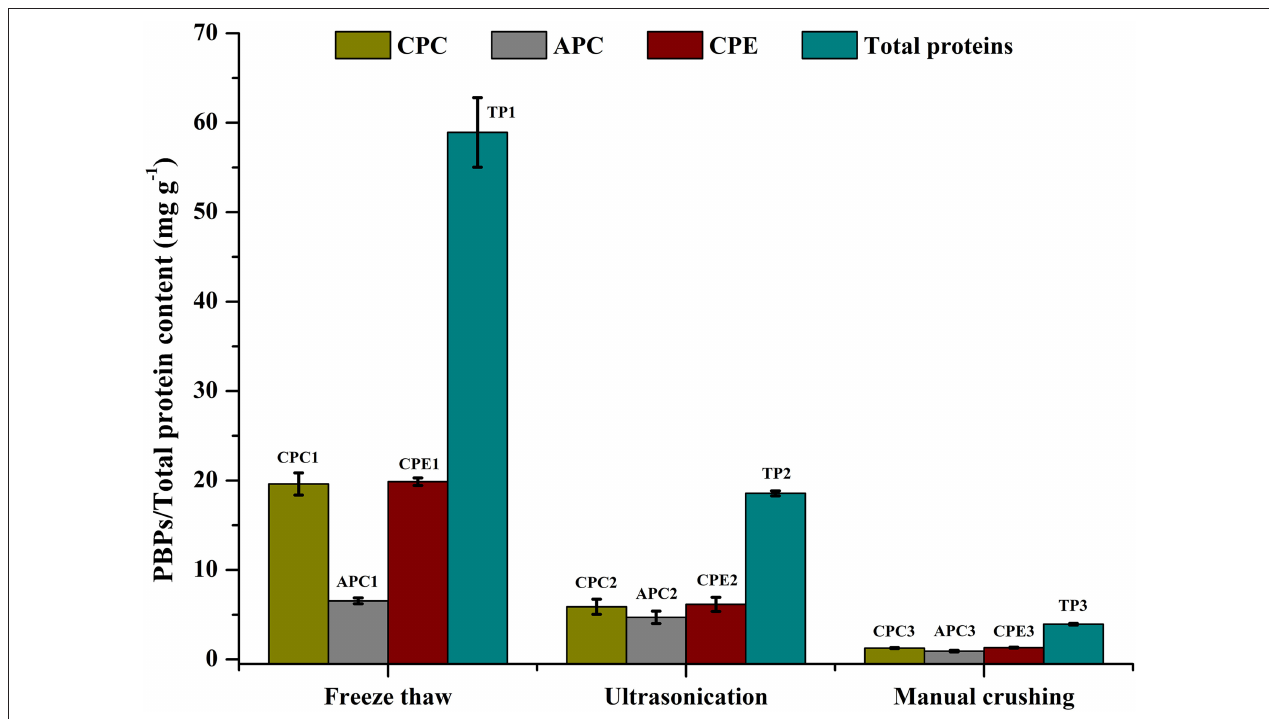
FIGURE 2 | Screening of different cell disruption methods for CPE and total protein extraction. Significance of each extracted analyte denoted by its initials followed by significance number. A different number denotes statistical significance ( p < 0.05, n = 3). TP, Total